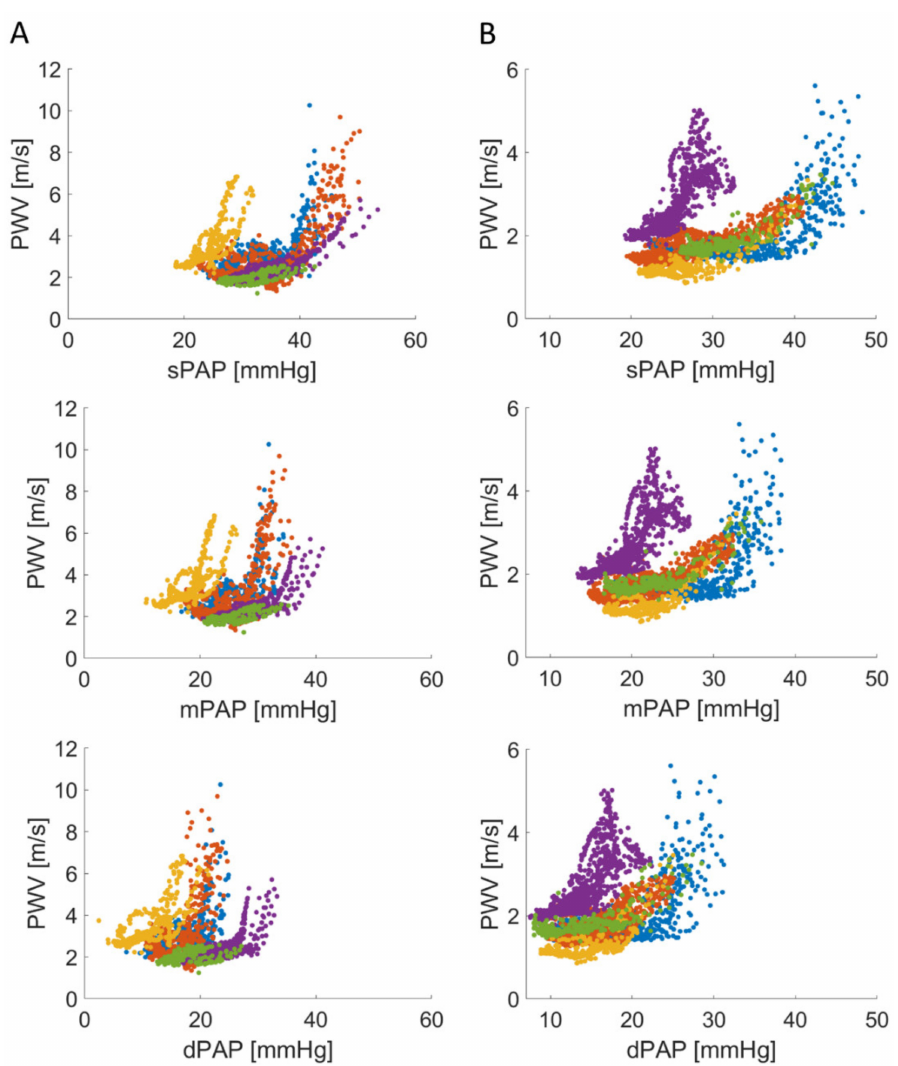
Figure 6. Hyperbolic correlation between sPAP, mPAP, dPAP and PWV during thromboxane A2- induced PH (( A ), n = 5, catheter distance unavailable in one animal) and hypoxic pulmonary vasoconstriction (( B ), n = 5). PWV was calculated as pressure sensor distance divided by PWTT given in m/s. For each animal an individual colour was